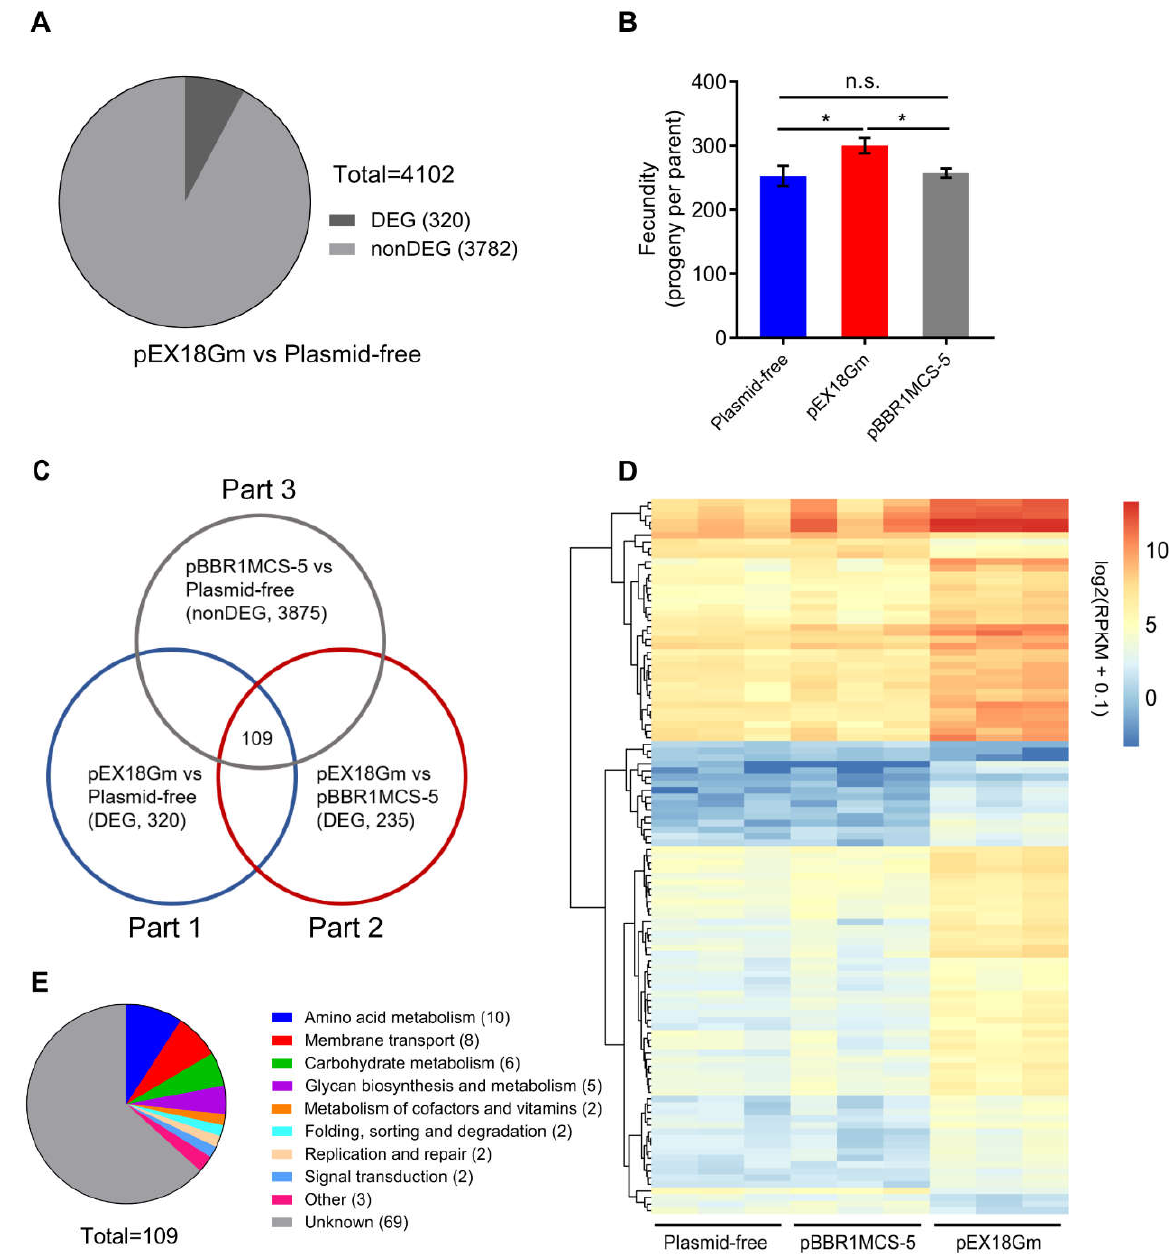
Figure 2. RNA-seq analysis of E. coli Strains. ( A ) Pie chart of comparing gene expression between E. coli OP50 (plasmid-free) and E. coli OP50 harboring plasmid pEX18Gm (pEX18Gm). DEG means significantly differentially expressed genes ( p < 0.05 and |log2(fold change)| > 1.5); nonDEG means insignificantly differentially expressed genes. ( B ) C. elegans fecundity response to feeding on E. coli OP50 harboring pEX18Gm and pBBR1MCS-5, respectively. * p < 0.05 by Tukey’s multiple comparison test; n.s. indicates not significant. ( C ) Venn diagram of candidate gene screening. Part 1 means significant differential expression genes between E. coli OP50 harboring pEX18Gm and plasmid-free E. coli OP50. Part 2 means significant differential expression genes between E. coli OP50 harboring pEX18Gm and pBBR1MCS-5. Part 3 means insignificant differential expression genes between E. coli OP50 harboring pBBR1MCS-5 and plasmid-free E. coli OP50. ( D ) Heatmap of 109 candidate gene expression. Expression values (RPKM) were log2 transformed. See Table S1 for details. ( E ) Pie chart about KEGG functional annotation of candidate gene. See Table S1 for details.